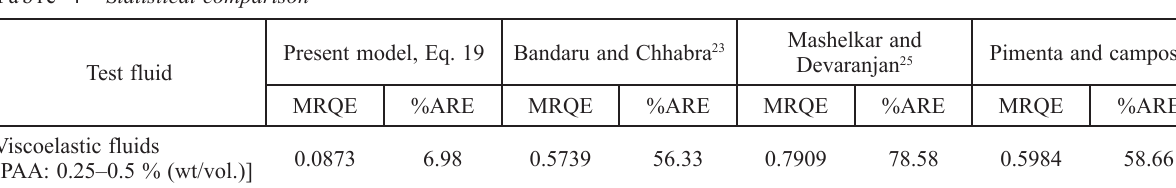
Table 4 – Statistical comparison Present model, Eq. Test fluid